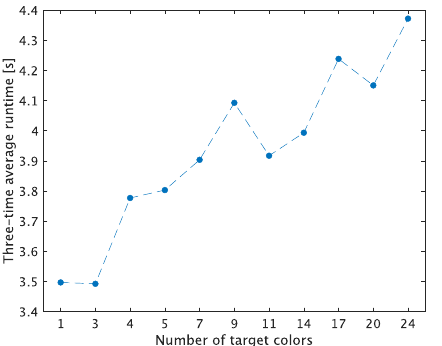
Figure 10. Three-time average runtimes for applying white balancing, three-color balancing, and Cheng’s method to 51 images. Among number of target colors, 1, 3, and over 4 indicate white balancing, three-color balancing, and Cheng’s method,